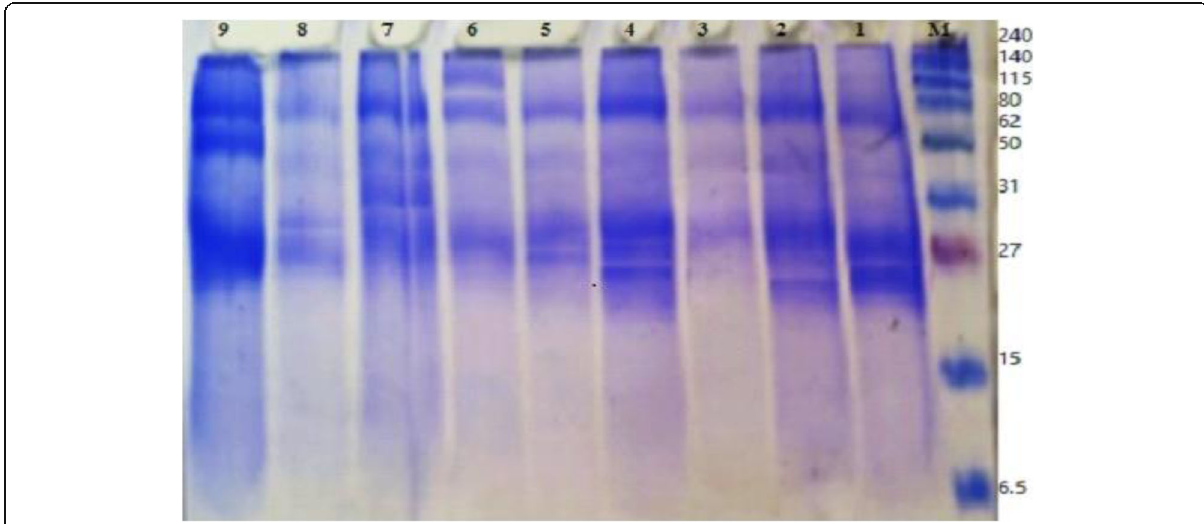
Fig. 1 Protein pattern of leaf-soluble protein of soybean grown under salinity stress and/or cysteine treatments by using SDS-PAGE. (1) control (tap water), (2) 20 mg/l cysteine + tap water, (3) 40 mg/l cysteine+ tap water, (4) 3000 mg/l sea salt, (5) 20 mg/l cysteine + 3000 mg/l sea salt, (6)